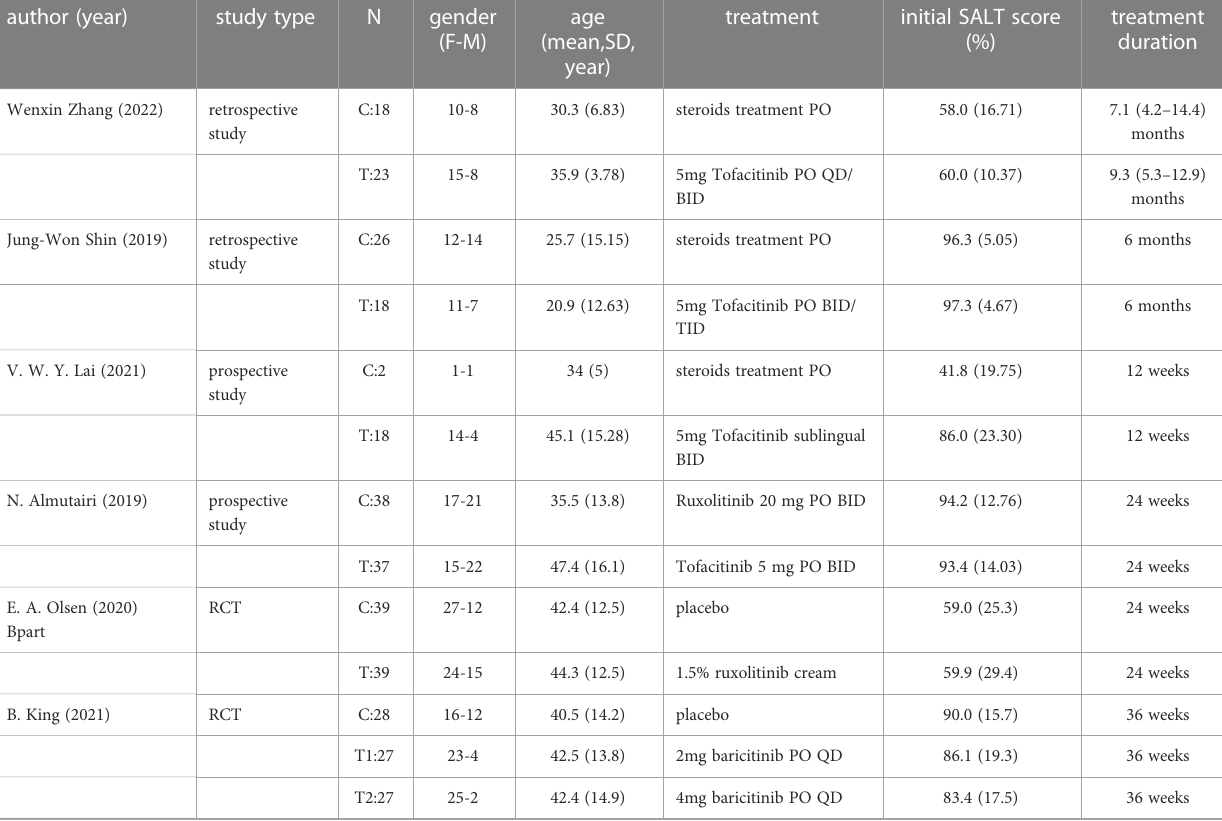
TABLE 1 Demographic and clinical characteristics of the patients at baseline.